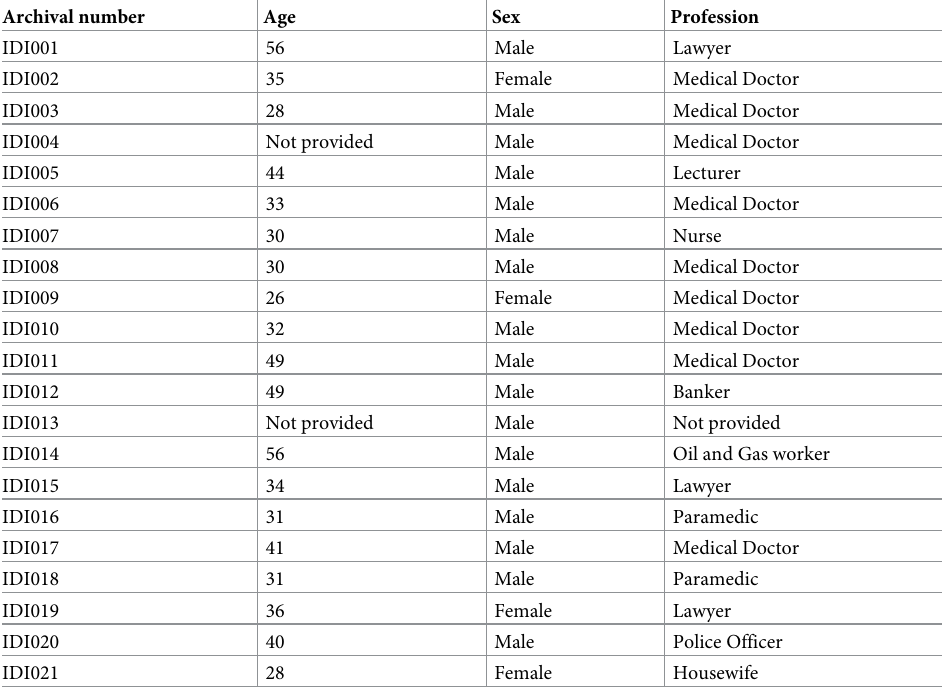
Table 1. Profile of the